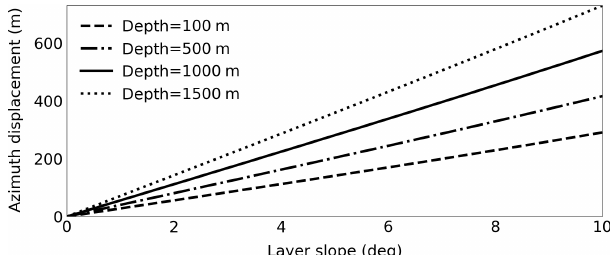
Figure 13. Internal-layer displacement in azimuth.